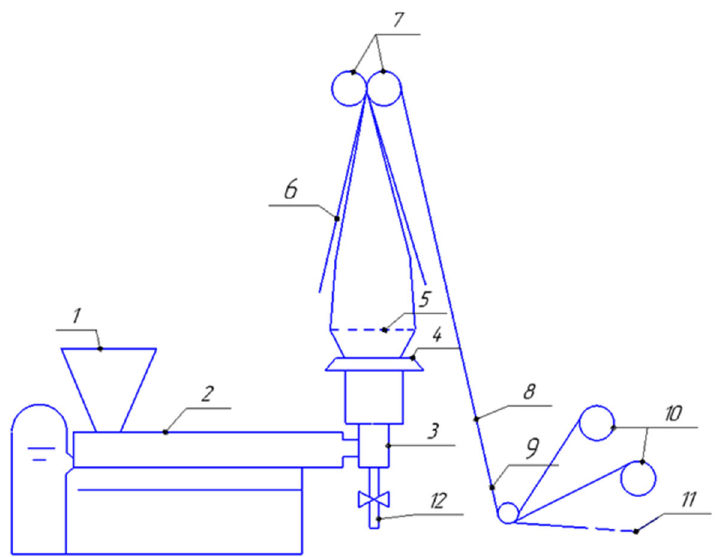
Figure 7. Technological diagram of an extrusion line for producing polypropylene film for sleeves: 1—bunker; 2—extruder; 3—annular angular head; 4—hollow ring for air cooling of the film sleeve; 5—crystallization line with height H; 6—folding cheeks; 7—pressure pulling rolls; 8—film; 9—knives for trimming edges; 10—winding device; 11—edges cut from the film; 12—branch pipe for supplying compressed air for inflation of the sleeve.